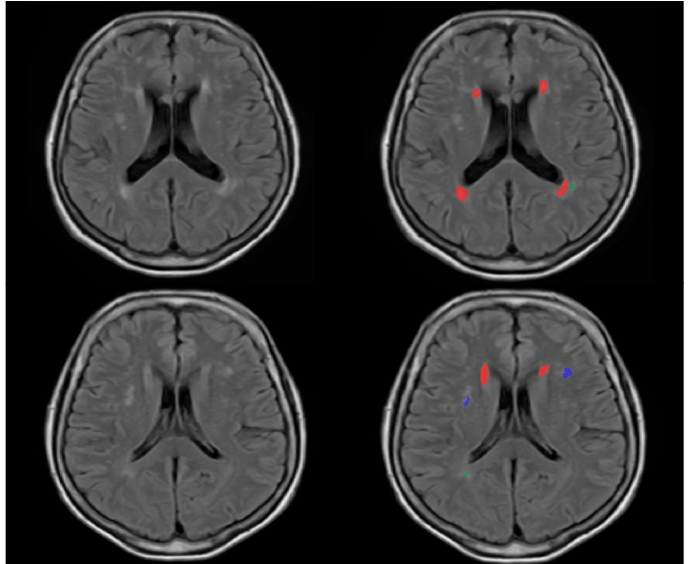
Figure 1. FLAIR MRI imaging of 65 years old female monozygotic twins (left column); the right side column pictures are the segmented version of the FLAIR images. The similarity of the anatomy and WMH of the cut is visible. According to our analysis, one twin has a total number of 17 WMHs (first row) and the other pair has a total number of 19 WMHs (second row). The red color represents the periventricular WMH and the blue and green colors represent the juxtacortical and deep white matter WMH—image from the Semmelweis University Medical Imaging Centre.